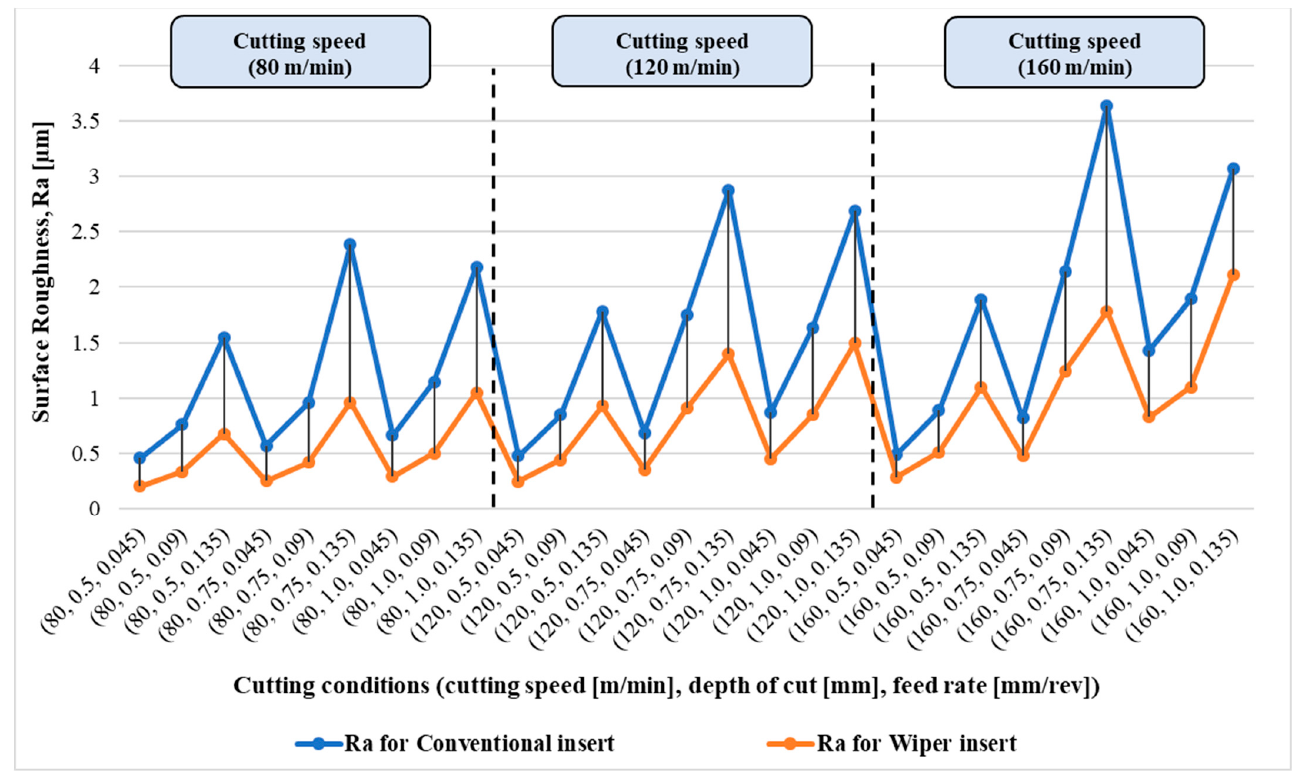
Figure 6. Resultant surface roughness, Ra in µm for both cases, of conventional and wiper inserts under a range of cutting conditions.